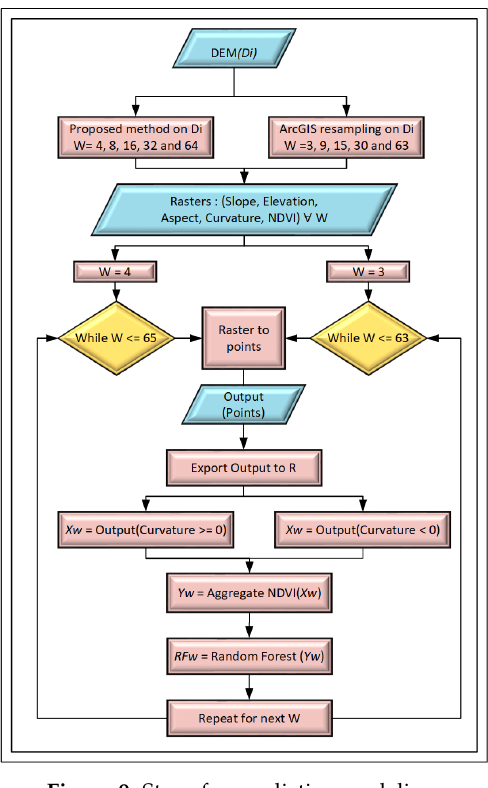
Figure 9. Steps for predictive modeling. Table 1. Accuracy and GINI importance results generated from Random Forest